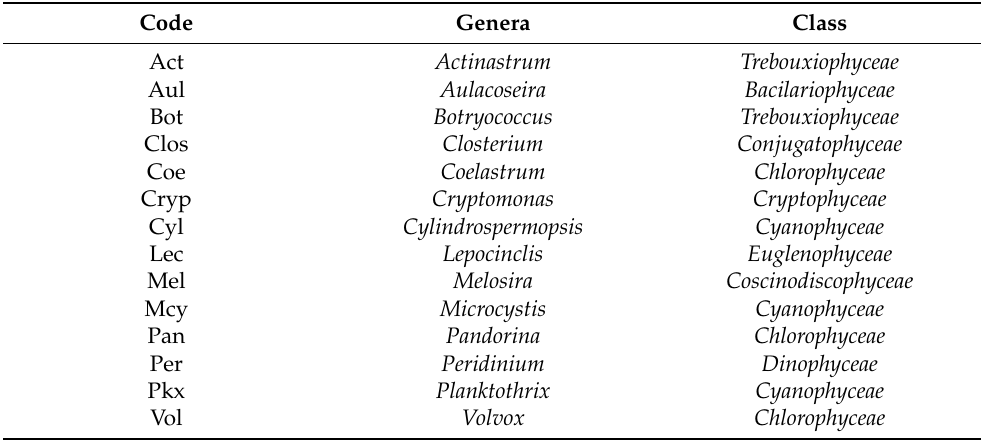
Table 2. List of the codes and class of phytoplankton species genera that stood out in the compromise factor map (see Figure